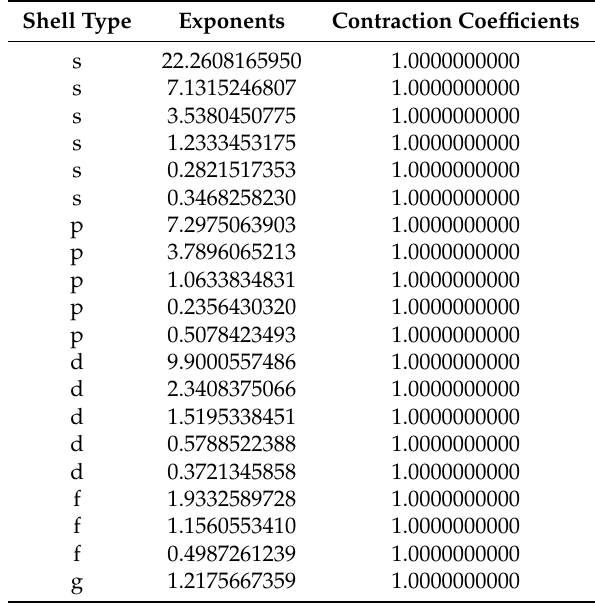
Table A19. Parameters of the cc-TZVP auxiliary basis set of Carbon. Parameters taken from [89].